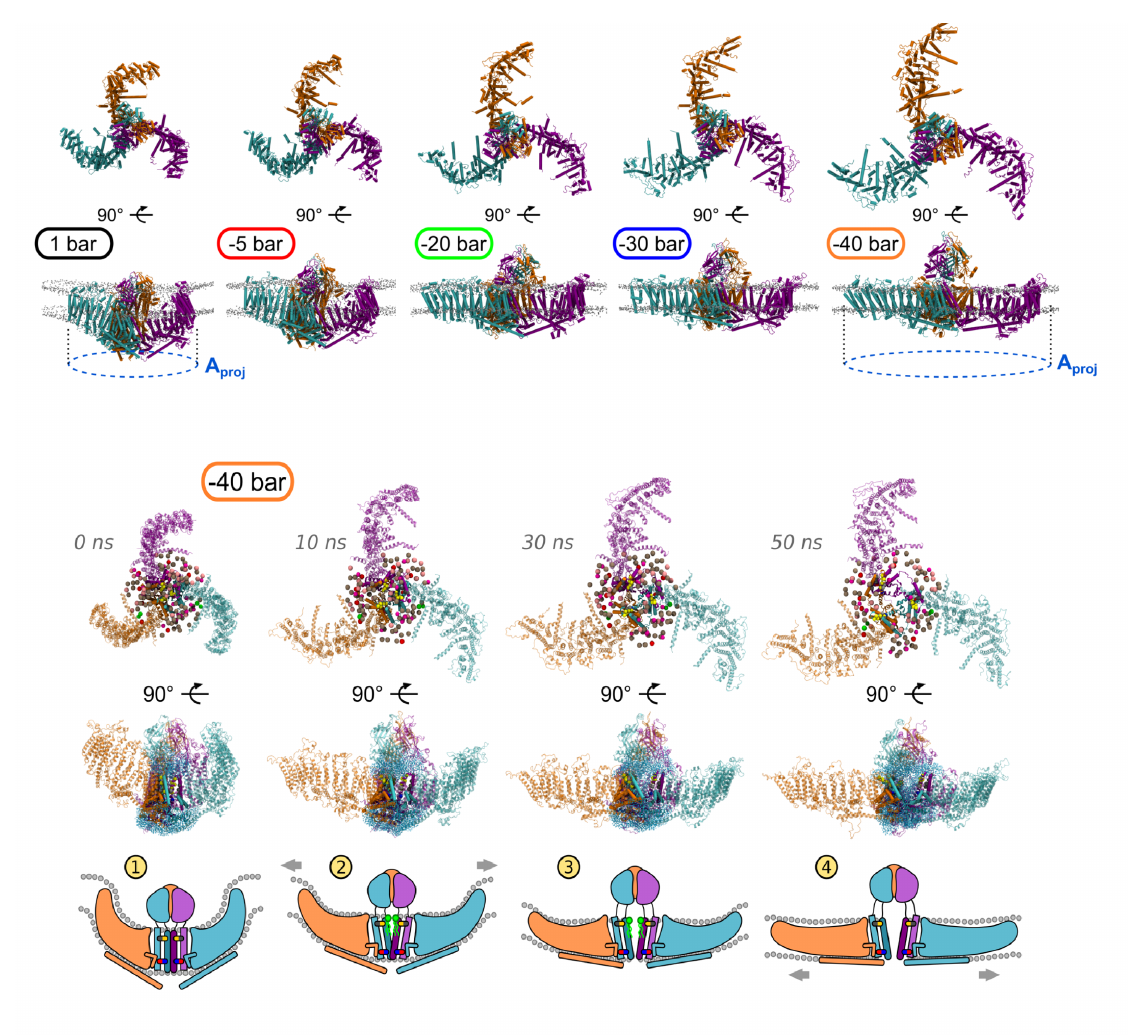
Figure 7. Membrane tension applied to Piezo1 channel via molecular dynamics simulations. In the upper panel, top and lateral views of Piezo1 channel flattening upon increasing membrane tension, up to − 40 bar. In the lower panel, a sequence of snapshots from MD simulation at − 40 bar, extracellular top view and lateral view, and cartoon representation explaining the Piezo1 activation mechanism coupled to membrane tension. Grey arrows indicate membrane tension and Piezo1 blade expansion. Adapted from [208], under CC–BY–NC–ND 4.0 International